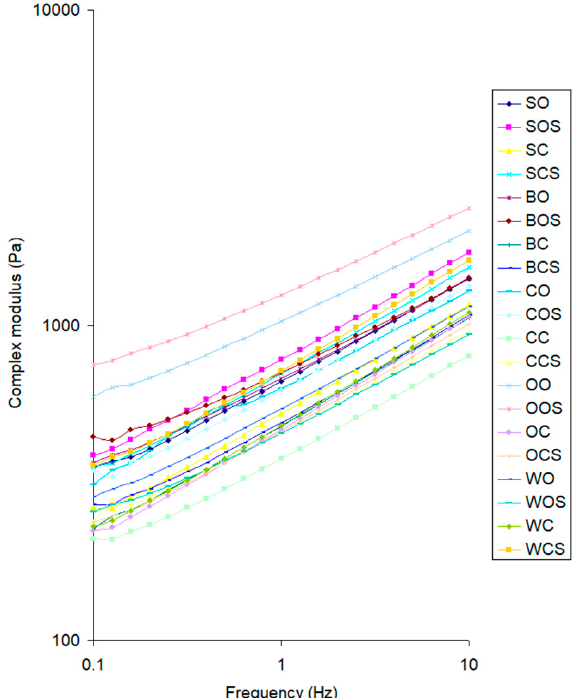
Figure 1. Influence of frequency on the complex modulus of different gluten samples (S—sugar beet; B—barley; C—clover; O—oats; W—wheat; O—organic system; C—conventional system; S—sonicated (e.g., BCS—barley in conventional system, sonicated). Table 7. Complex modulus (Pa) of gluten